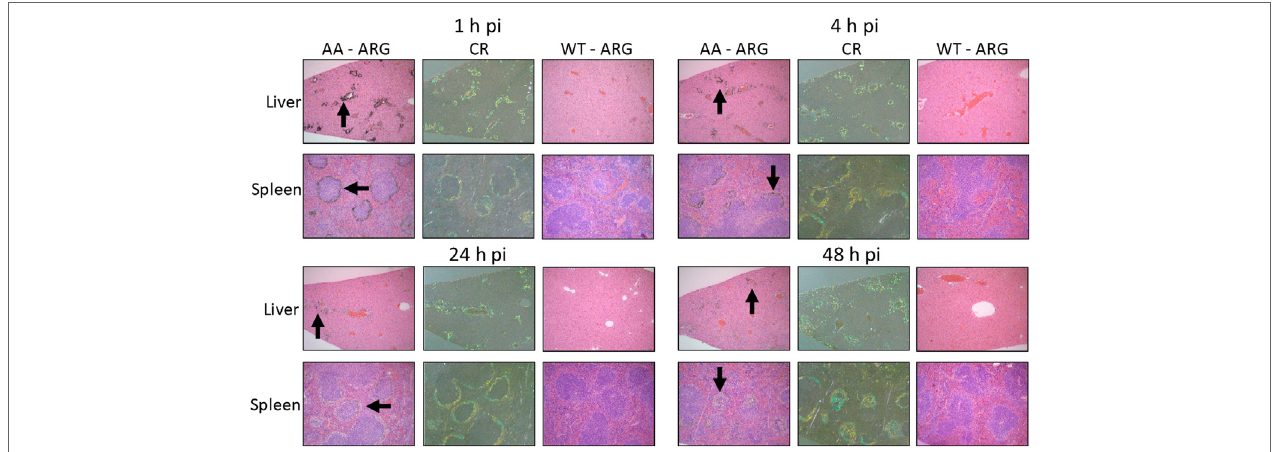
FigUre 7 | 125 I-Fcp5 binds AA amyloid deposits in vivo . The presence of 125 I-Fcp5 in the liver and spleen at 1, 4, 24, and 48 h postinjection (pi) was evidenced by the presence of black silver deposits (arrows) in autoradiographs (ARG). The tissue distribution of 125 I-Fcp5 correlated with the presence of amyloid seen as green-gold birefringent material in Congo red-stained (CR) consecutive tissue sections. No evidence of specific binding of 125 I-Fcp5 to wild-type (WT) liver and spleen was